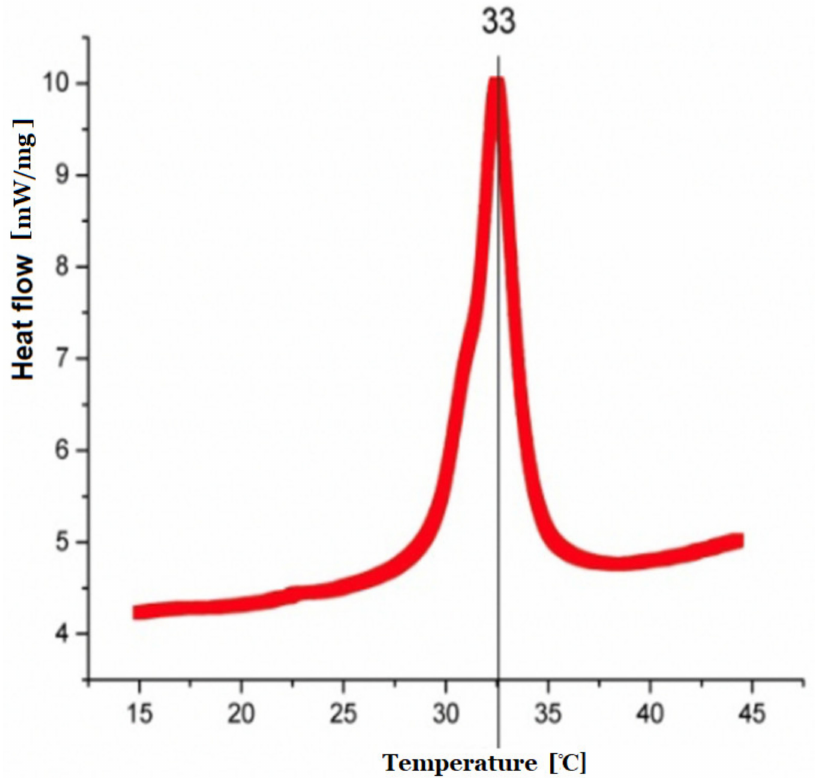
Figure 3. DSC measurement with characteristic increase in heat flow representing phase